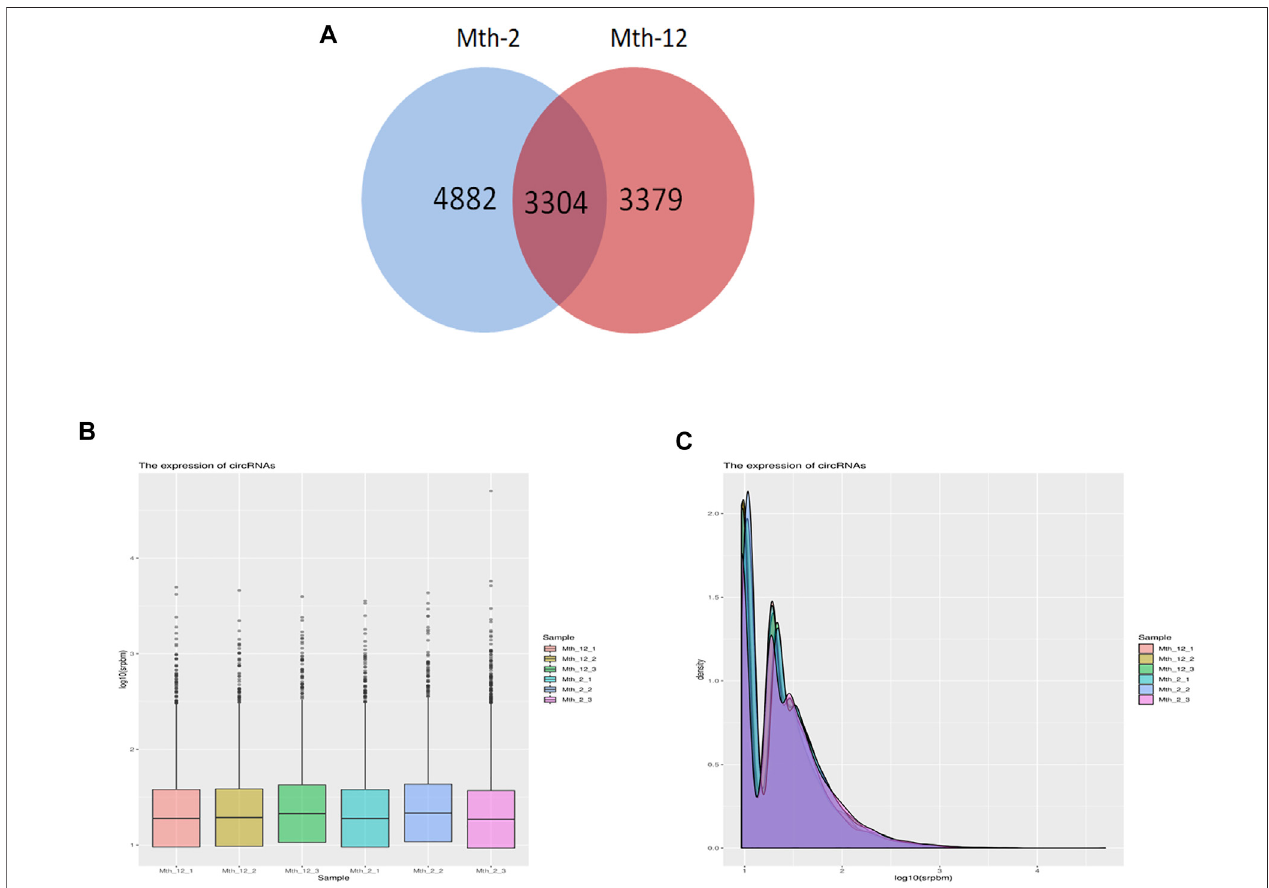
FIGURE 2 | CircRNA expression. (A) Venn diagram, drawn using the number of circRNAs in the two age groups; (B) circRNA expression; (C) The peak density of circRNA